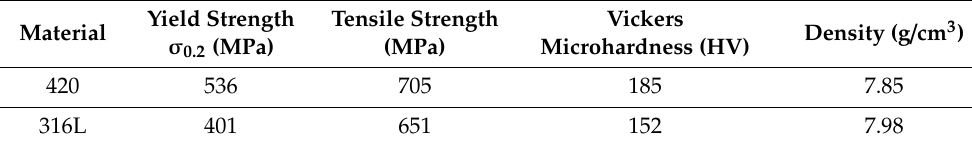
Table 2. Mechanical properties of 420 and 316L .